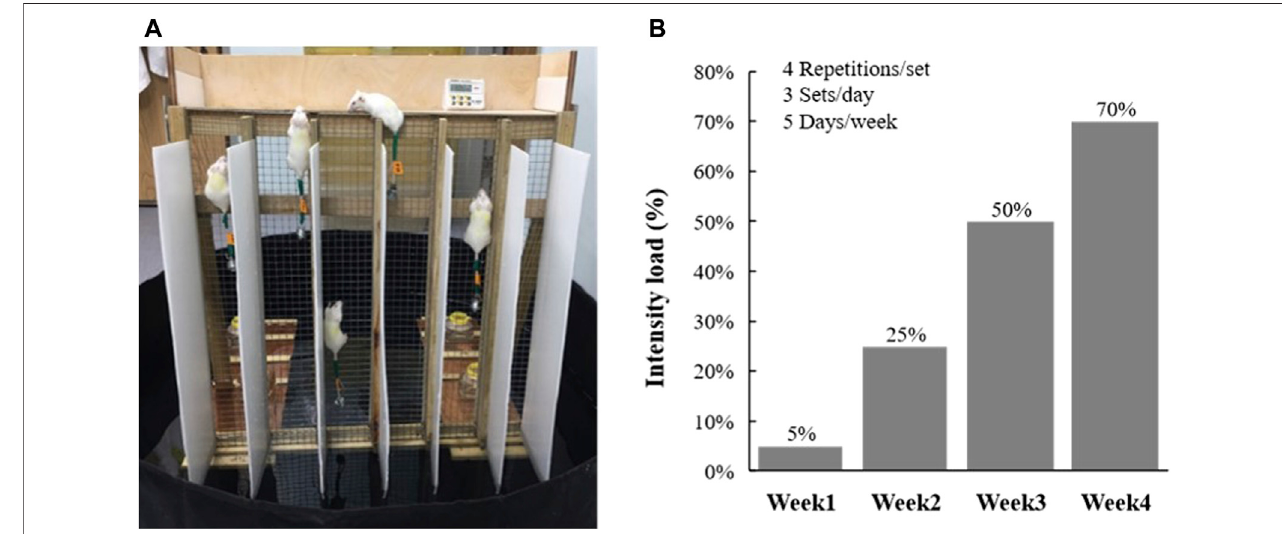
FIGURE 1 | (A) Climbing device for resistance training. (B) Incremental loading intensity applied to current training